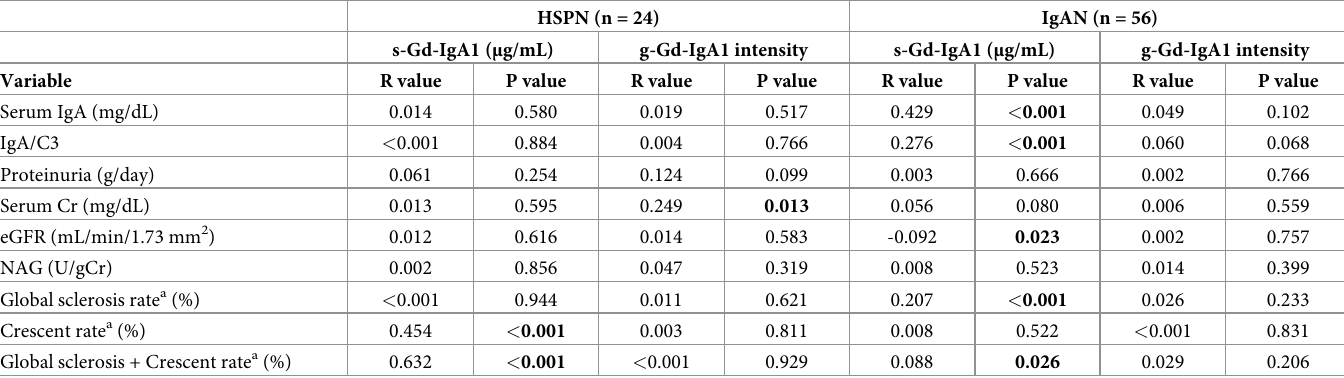
Table 3. Correlation between both types of Gd-IgA1 and clinicopathologic parameters in patients with HSPN or